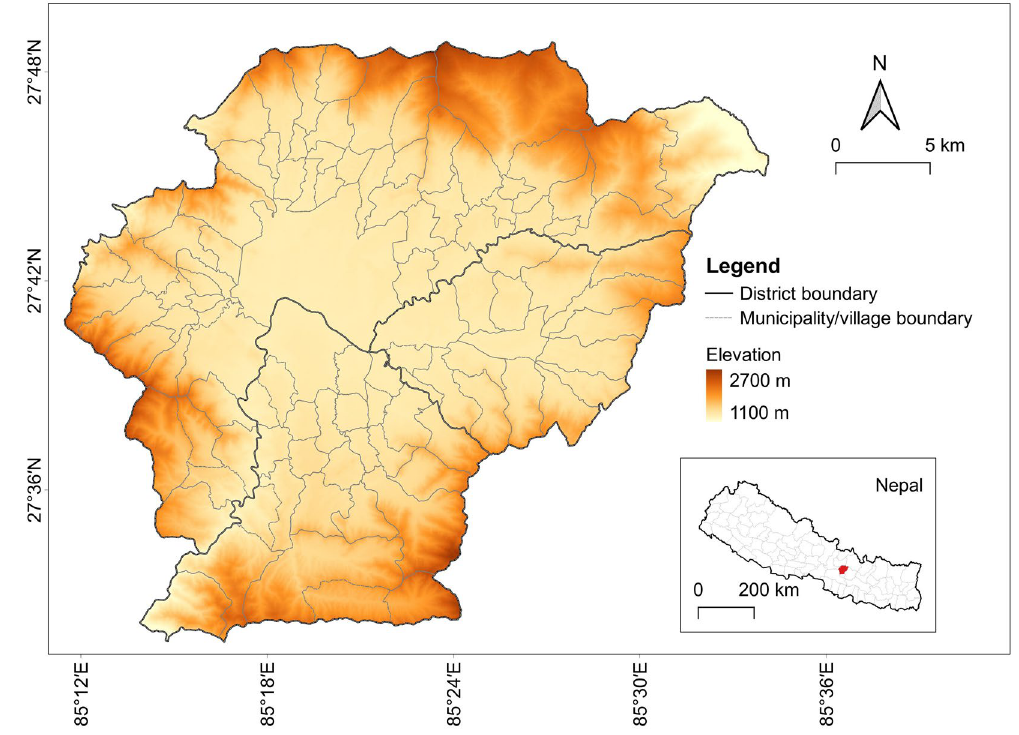
Figure 1. Physical and administrative map of Kathmandu